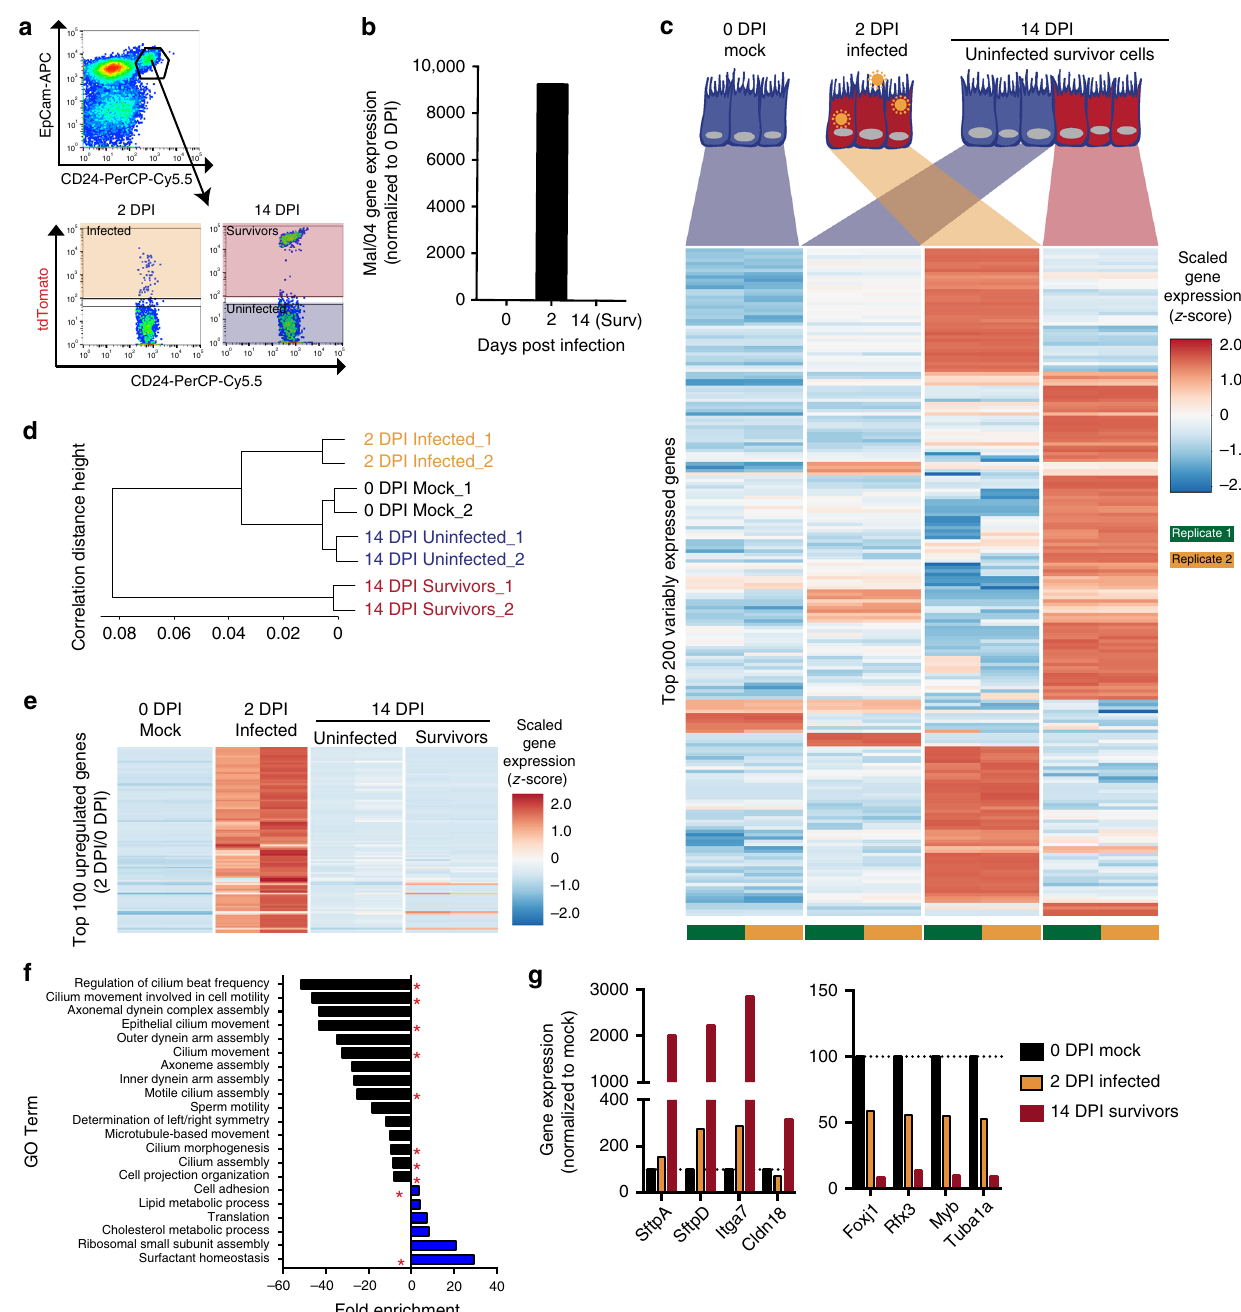
Fig. 4 Actively infected and uninfected ciliated cells are transcriptionally distinct from matched populations of survivor cells. a FACS gating strategy to isolate CD45- EpCam + CD24 + (ciliated) cells from the lungs of Mock and Mal/04-Cre infected mice. Cre-activated tdTomato expression was used to identify 2 DPI infected and 14 DPI survivor cells. b Viral mRNA gene expression of the Mal/04 genome in 2 DPI infected and 14 DPI survivor cells (Normalized to 0 DPI). c Heatmap of the top 200 variably expressed genes across the four conditions (eight samples total) from murine lung ciliated cells: 0 DPI mock, 2 DPI actively infected with virus, 14 DPI tdTomato − uninfected and 14 DPI tdTomato + survivor cells (14 DPI samples collected from the same lungs). Gene expression has been normalized using DeSeq2 ’ s default scaling factor parameters and normalized using a shifted log transformation [log 2 ( n + 1)]. Expression was then scaled across rows and the relative z -scores plotted. d Measurement of correlation distance between the indicated samples using Spearman ’ s rank test. e Heatmap of top 100 genes upregulated in 2 DPI cells compared to 0 DPI mock cells. Gene expression was then scaled across rows and the relative z -score plotted. f Gene Ontology of Biological Processes generated using DAVID software for genes differentially expressed between 14 DPI tdTomato − (uninfected cells) and 14 DPI tdTomato + (survivor cells) red asterisks indicate GO processes that are associated with dysregulated cilia function or gene pathways not expected to be active in normal ciliated cells. g RNAseq gene expression, normalized to 0 DPI mock cells, for selected dysregulated genes derived from the pathways identi fi ed in the ontology analysis in